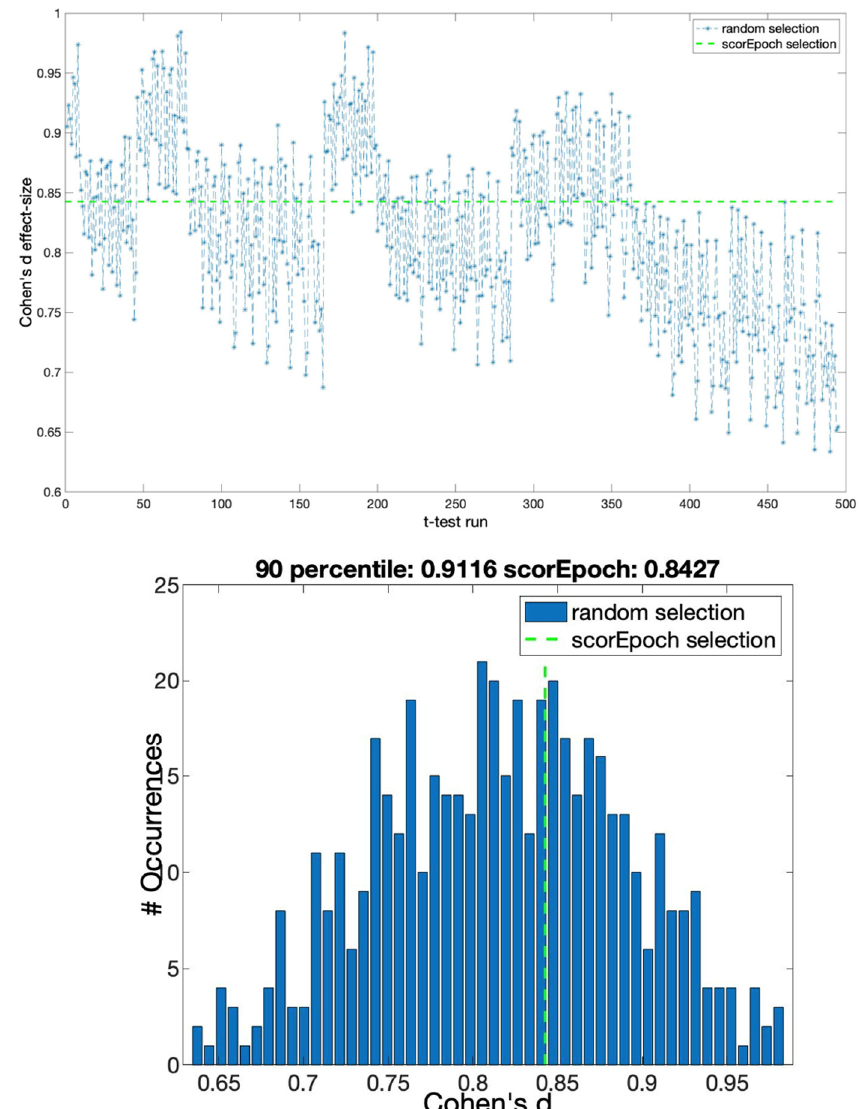
Figure 5. Cohen’s d effect sizes for random selection and Scorepoch selection using a time window equal to 5 s for the PLI method. ( upper panel ) The ‘time course’ of the effect size computed using a sequential random selection. The effect size values are reported in the y-axis, while the x-axis indicates the t-test with a sequential random selection. The green dashed line represents Cohen’s d value obtained by selecting the epochs using Scorepochs. ( lower panel ) Cohen’s d effect size distribution for the random epoch selection and the Scorepoch selection. The effect size values are reported on the x-axis, while the y-axis indicates the occurrences of specific effect size values. The vertical green dashed line represents Cohen’s d value selecting the 4 epochs suggested by Scorepochs.